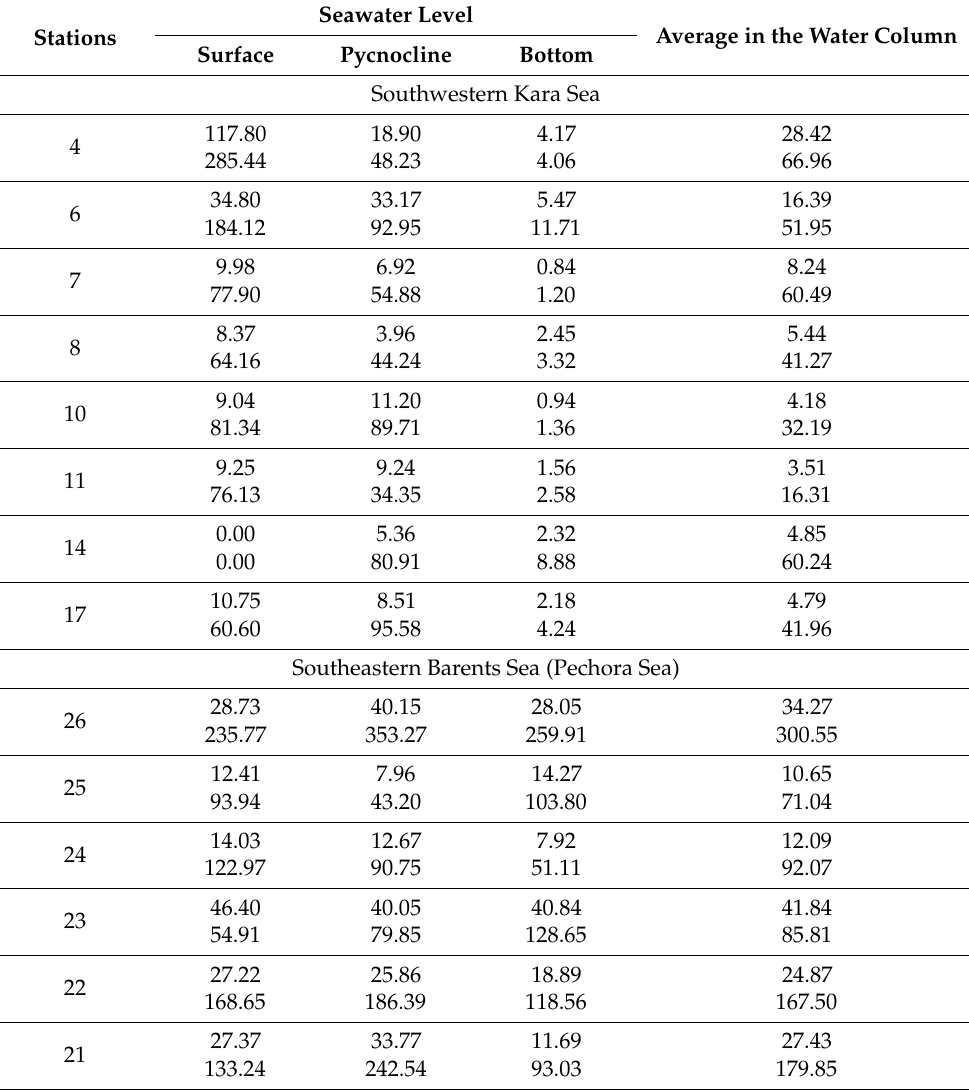
Figure 11. Phytoplankton biomass (µg/L) in the three investigated seawater layers at sampling stations located in the southwestern Kara Sea ( a ) and the southeastern Barents Sea ( b ). Table 2. Total abundance (thousand cells/L, numbers above the lines) and biomass ( µ g/L, numbers below the lines) of phytoplankton in the water areas under